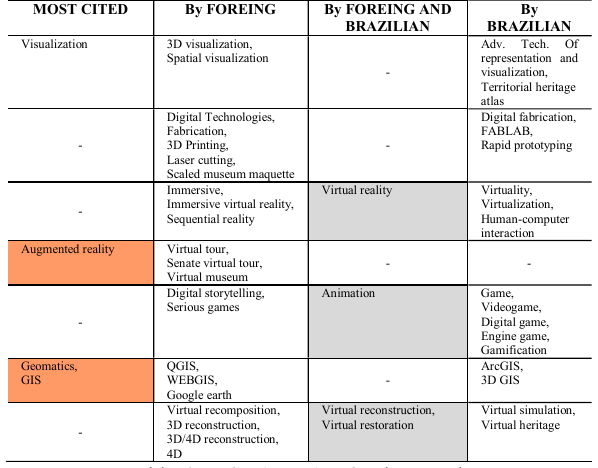
Table 6: VISUALIZATION